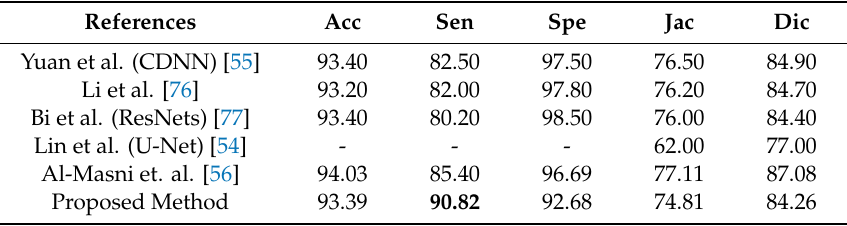
Table 4. The comparison of the proposed method skin lesion segmentation performance (%) with the latest studies in the literature.